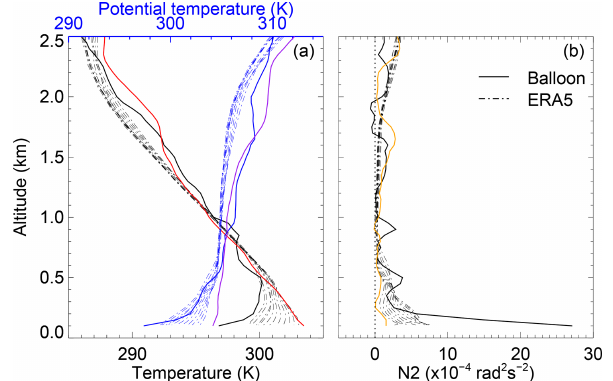
Figure 5. (a) Temperature (black solid line) and potential tempera- ture (blue solid line) profiles from radiosonde at 07:15 on 5 Septem- ber and ERA5 (dash-dotted lines) between 22:00 on 4 September and 08:00 on 5 September. Profiles of temperature (red solid line) and potential temperature (purple solid line) from the radiosonde at 19:15 on 4 September are also plotted. (b) Corresponding buoy- ancy frequency profiles from radiosonde (black solid line) at 07:15 on 5 September and ERA5 (dash-dotted lines) between 22:00 on 4 September and 08:00 on 5 September. The buoyancy frequency pro- file (orange solid line) from the radiosonde at 19:15 on 4 September is also plotted.